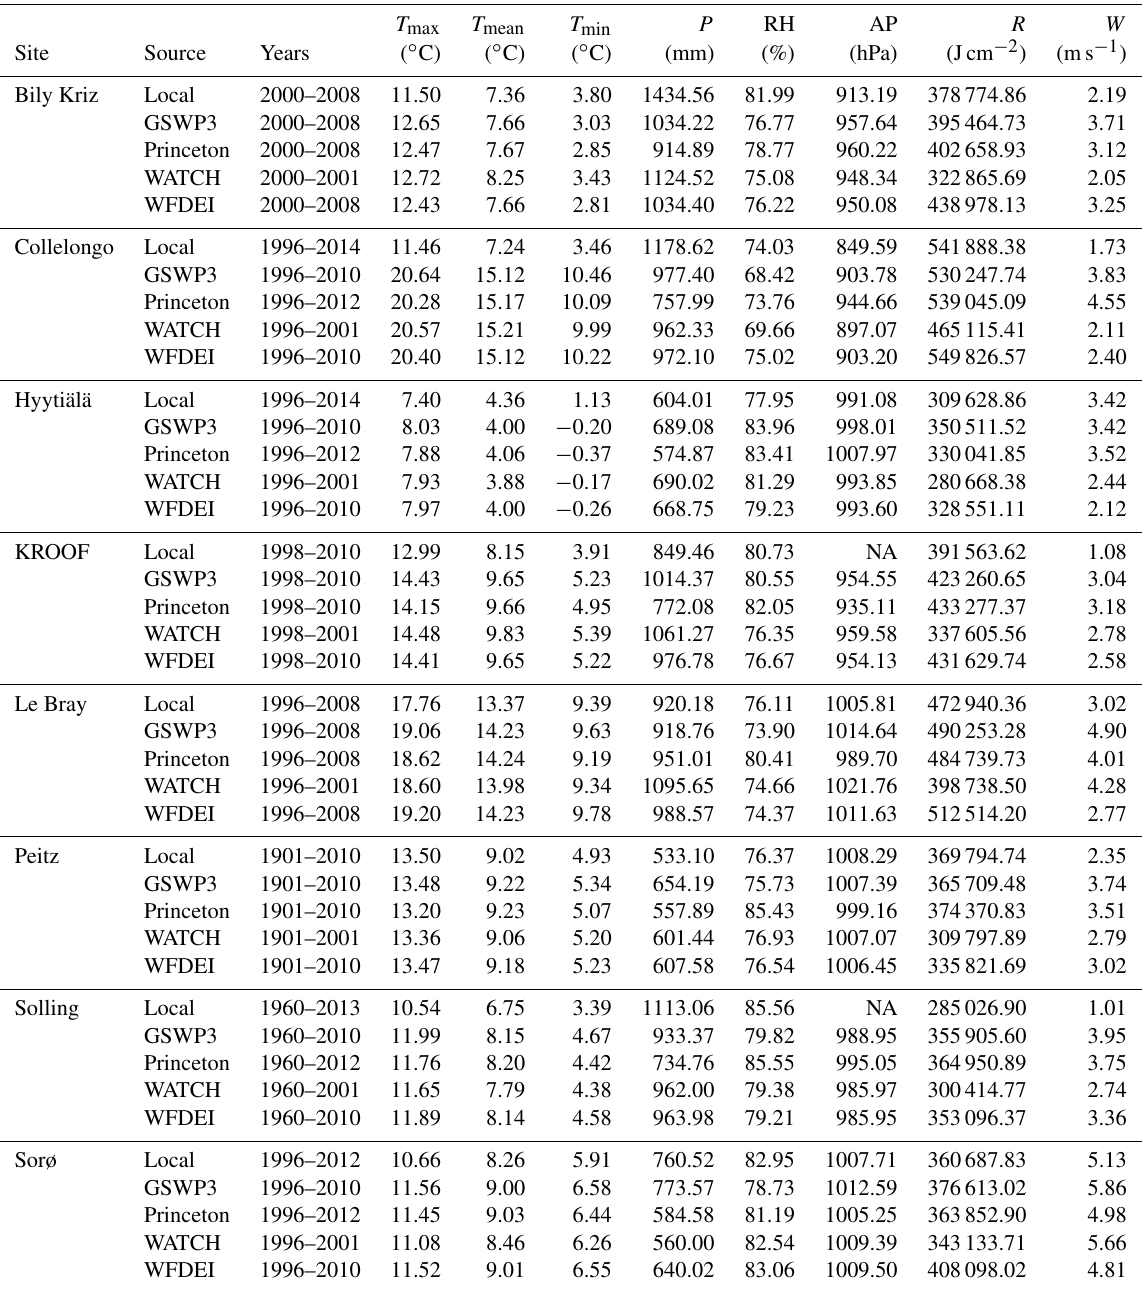
Table 3. Averages of the daily maximum temperature ( T max ), daily minimum temperature ( T min ), daily mean temperature ( T mean ), annual precipitation sum ( P ), daily mean relative humidity (RH), daily mean air pressure (AP), annual sum of global radiation ( R , direct + diffuse shortwave radiation) and daily mean wind speed ( W ) for each of the sites in the PROFOUND DB from five different sources: a locally observed climate and four different global reanalysis/observational products (GSWP3, Princeton, WATCH, WFDEI). The column “Year” indicates the years for which the mean climates have been calculated for the different sources. Please note that the two Solling sites have the same climate. NA: not